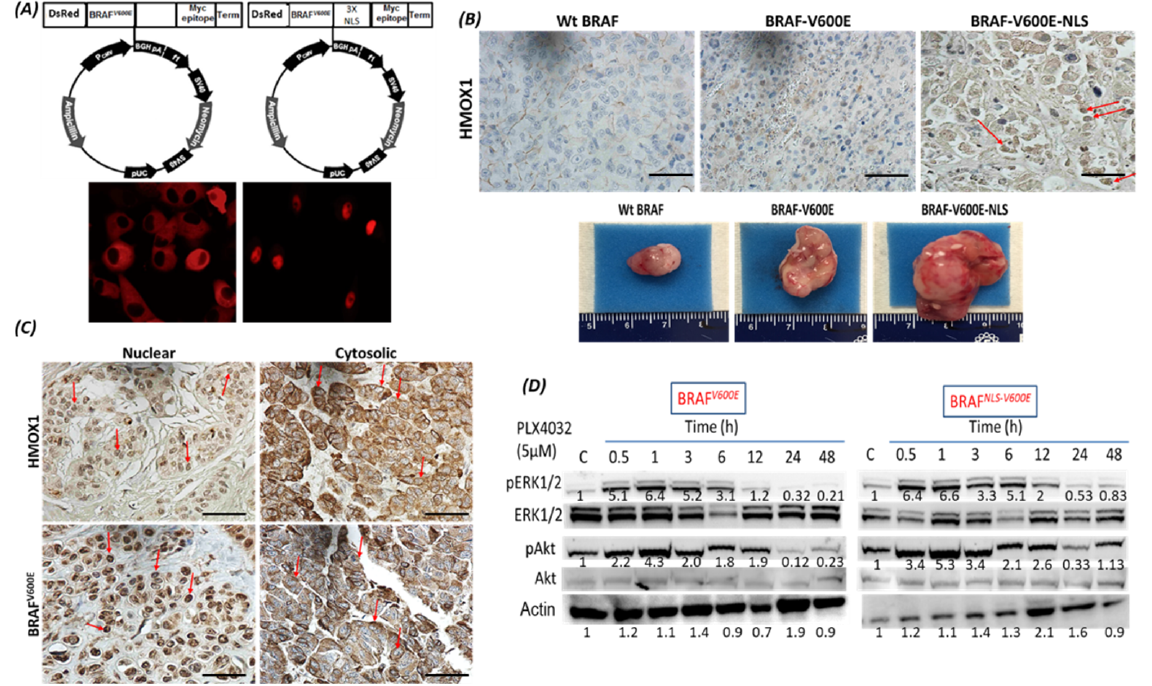
Figure 3. Nuclear BRAF V600E and HMOX-1 expression in xenograft mouse and human